Question: According to this chart, does the measure grow or shrink?
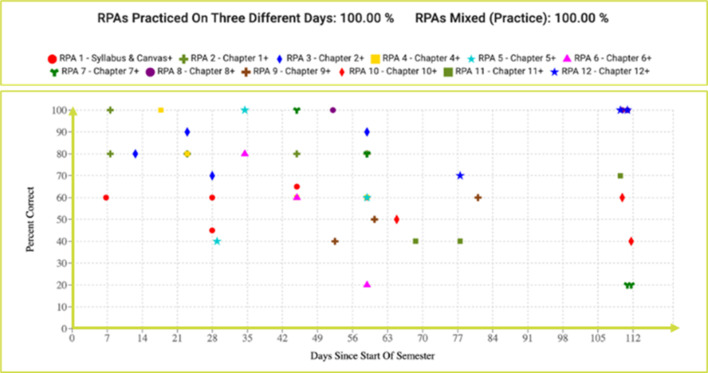
Answer: increasing